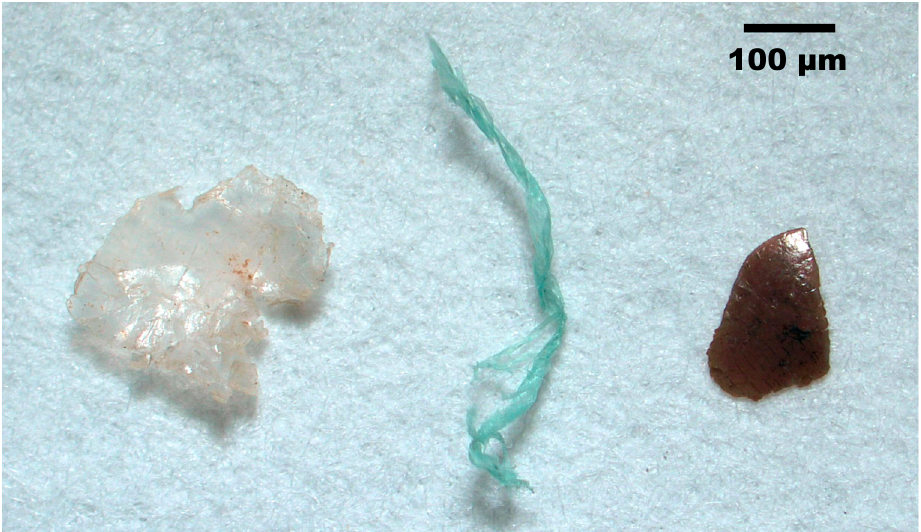
Figure 3. Micrograms of three types of microplastics. The scale bar indicates 100 μ m. From left to right: film (FL), fibre (FB) and hard fragment (FM).